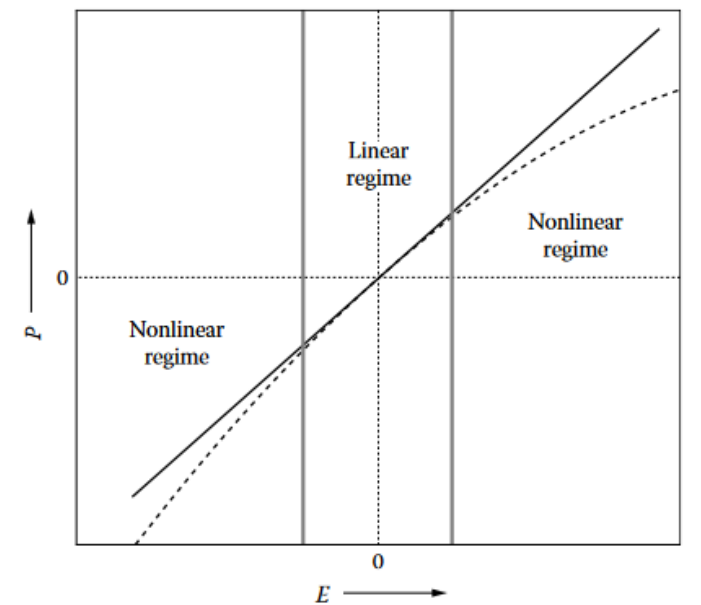
Figure 1. Depending on the intensity of the incident electric field ( E ), the electric polarization ( P ) will respond linearly or nonlinearly. As long as the intensity of the electric field is small, the electric polarization is linear to the electric field intensity. This case corresponds to the linear regime. When the intensity of the electric field is high, P is not proportional to E and the regime is nonlinear. Reproduced from Verbiest, T., Clays, K., and Rodriguez, V., 2009. Second-order Nonlinear Optical Characterization Techniques: An Introduction, with permission from Taylor and Francis Group, LLC, a division of Informa